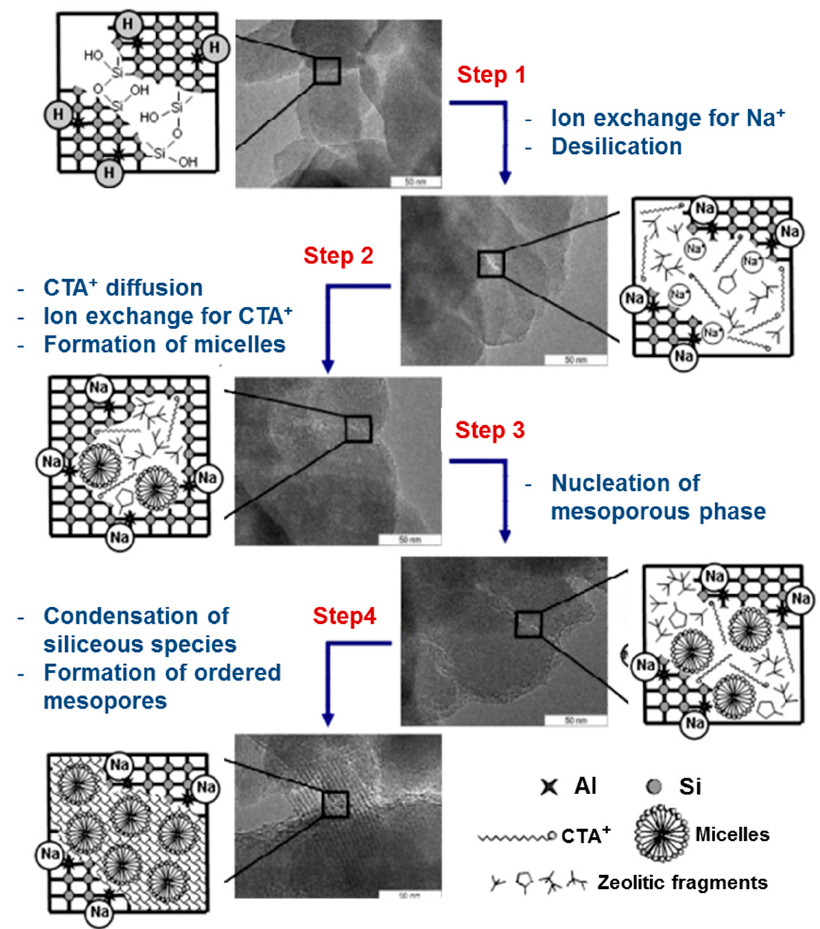
Figure 6. Schematic illustration of the major steps of mordenite recrystallization mechanism. Adapted with permission from [67]. Copyright Royal Society of Chemistry, 2014.